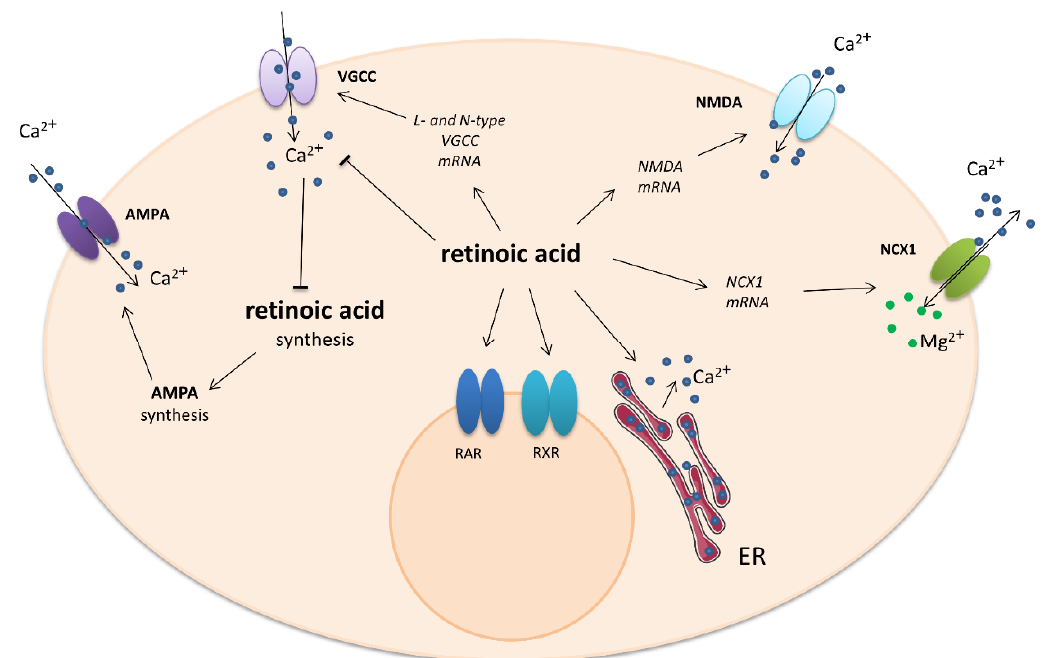
Figure 2. Impact of retinoic acid on intracellular calcium-involved actions. Arrows—stimulation or calcium influx/efflux; T-bars—inhibition of pathway. ER—endoplasmatic reticulum